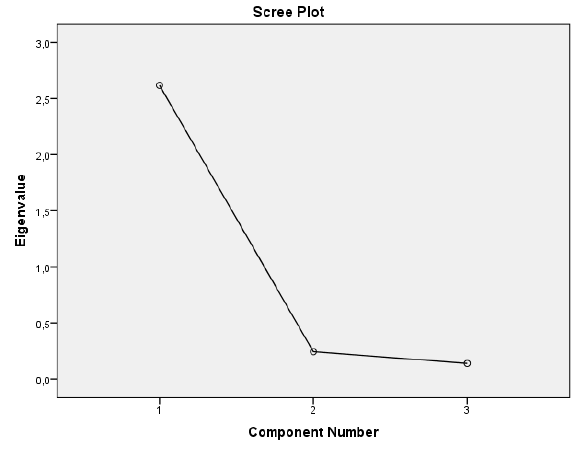
Figure 2: Scree Plot of ILS Factor loadings are examined in EFA analysis and the values are founded as higher than 0,30. The factor loadings are vary between 0,838 and 0,903. Cronbach Alpha coefficients were calculated for the reliability of the scores obtained from ILS. According to the results, one component extracted for the ILS scale. Cronbach's alpha coefficient was calculated for the reliability of the scores obtained from the ILS. The obtained value was calculated as